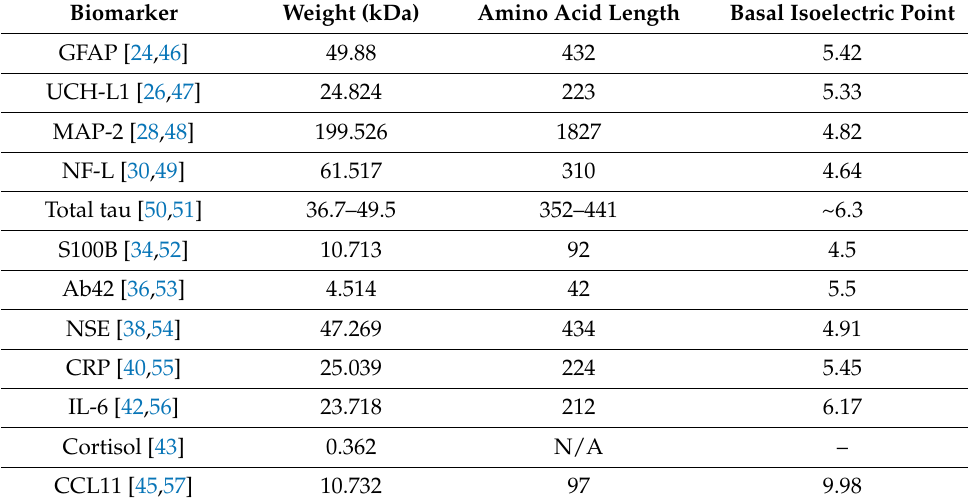
Table 2. The molecular weight, amino acid length, and basal isoelectric point (the pH value at which it is electrically neutral) of the identified